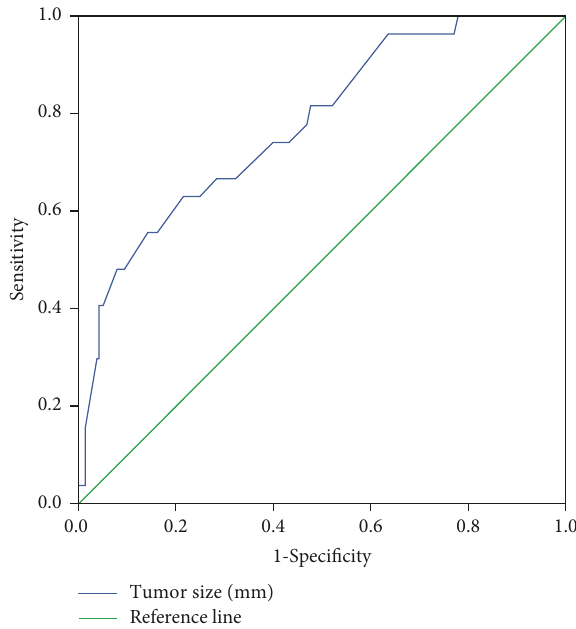
Figure 3: According to the ROC curves, the size of 54.5 mm yielded the highest accuracy in TCGA and COMETE cohort (AUC = 0.778, sensitivity=66.7%,specificity=61.6%,and p < 0.001).ROC:receiver operating characteristic; AUC: area under the